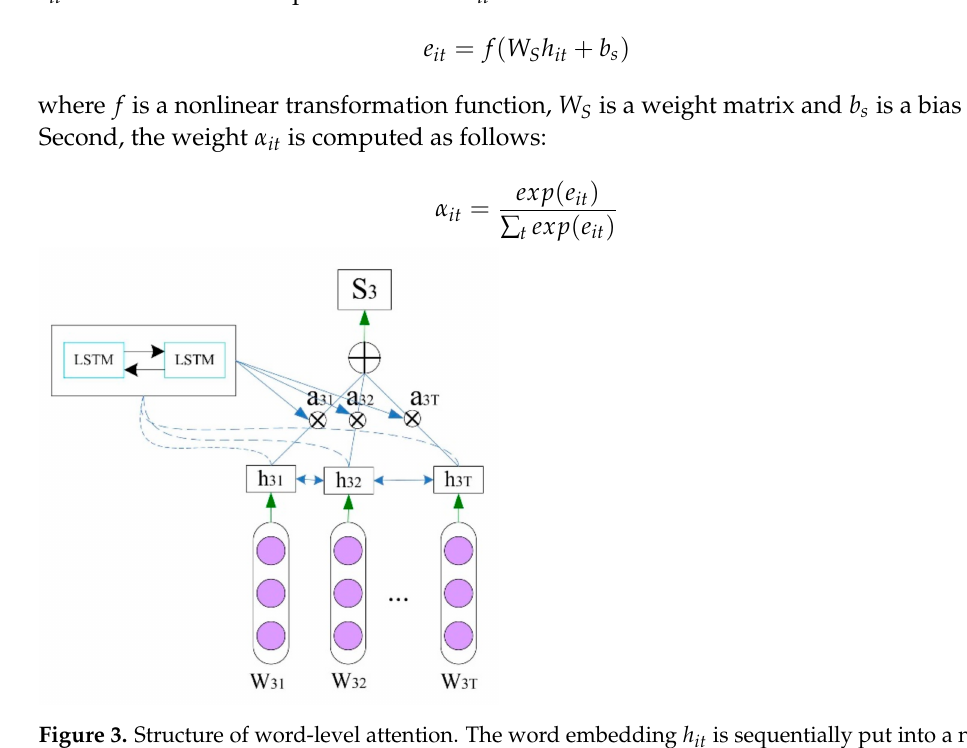
Figure 3. Structure of word-level attention. The word embedding h it is sequentially put into a neural network BiLSTM, α it are weights for h it , and S i is the sentence vector computed by weighting